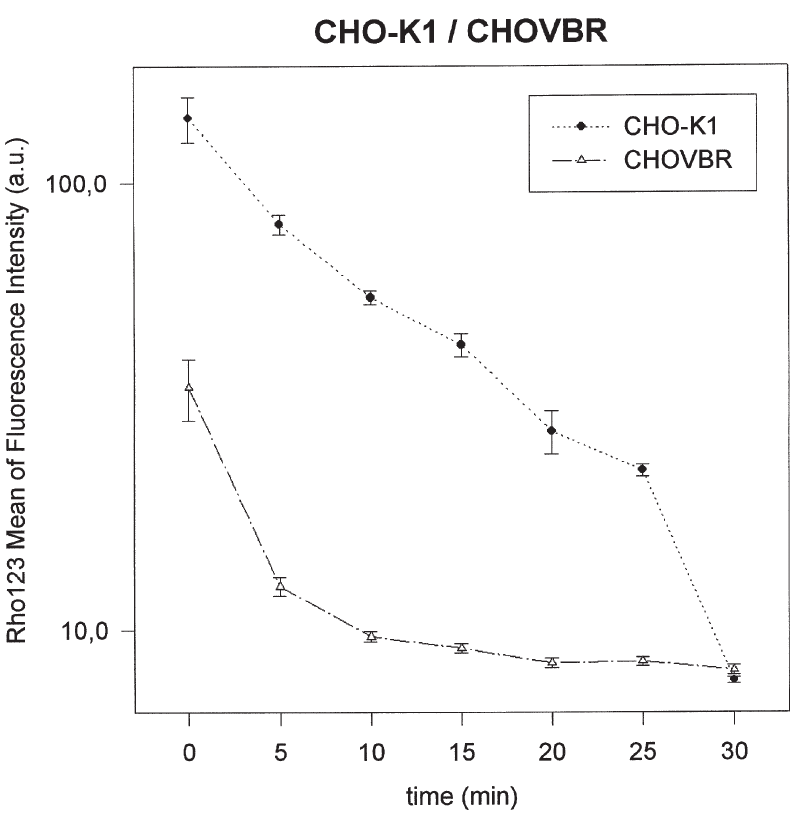
Fig. 4. Flow cytometry assessment of P-glycoprotein activity with chinese hamster ovary CHO-K1 ( " ) and CHOVBR ( P ) cell lines. Cells were precharged with 200 ng/ml of rhodamine 123 in a cell incubator. After 1 h incubation, cells were washed and resuspended in Rho123 free medium, for 30 min at 37 ◦ C. Fluorescence arbitrary units (a.u.) were calculated in terms of mean of fluorescence